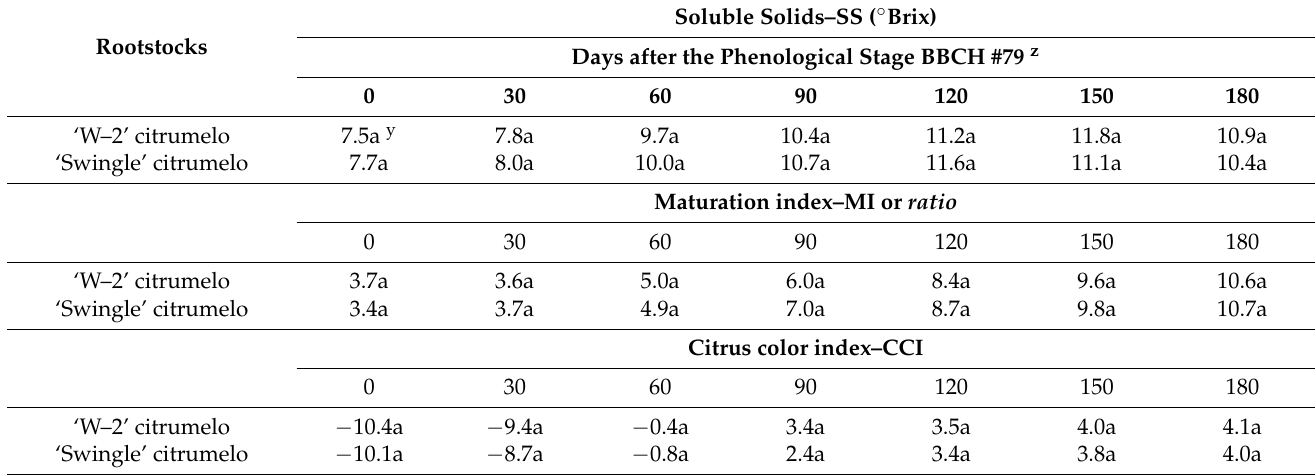
Table 6. Soluble solids, maturation index or ratio , and citrus color index of ‘Valencia’ orange fruits when trees are grafted on different ‘Trifoliata’ hybrid rootstocks at S ã o Jer ô nimo da Serra-SJS location at different times after the phenological stage BBCH